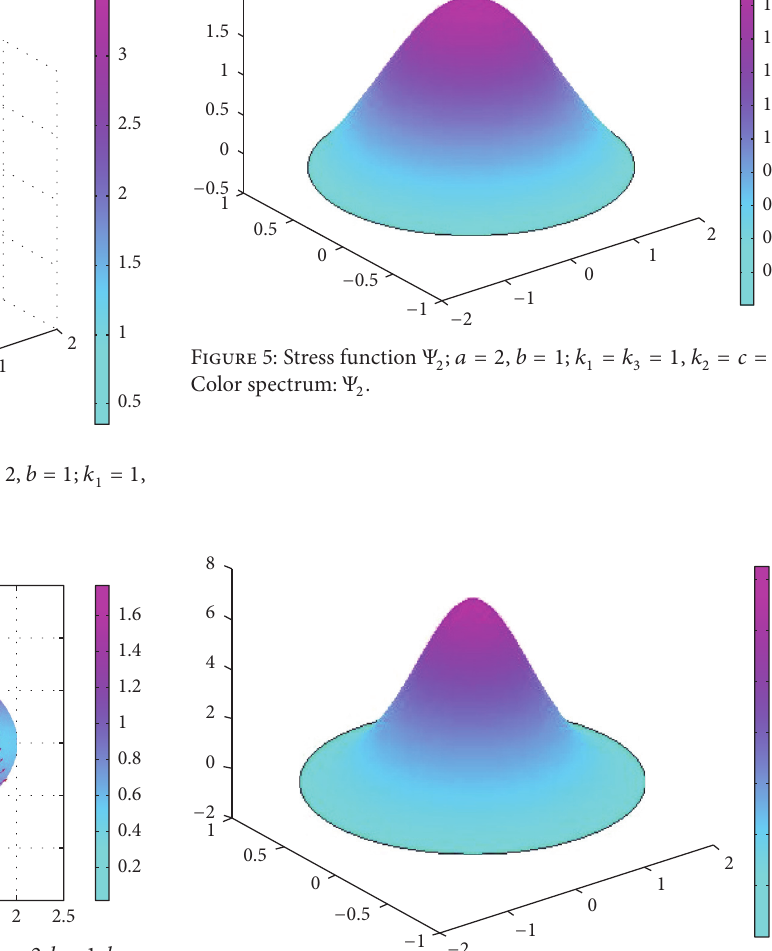
Figure 3: Tangential strain field per unit twist 𝛾 /𝛼 ; 𝑎 = 2 , 𝑏 = 1 ; 𝑘 1 = = 1 , 𝑘 = 2 . Color spectrum: ‖ 𝛾 (𝑥, 𝑦)‖ fl [𝛾 2 𝑘 3 2 for 𝛼 = 1 .